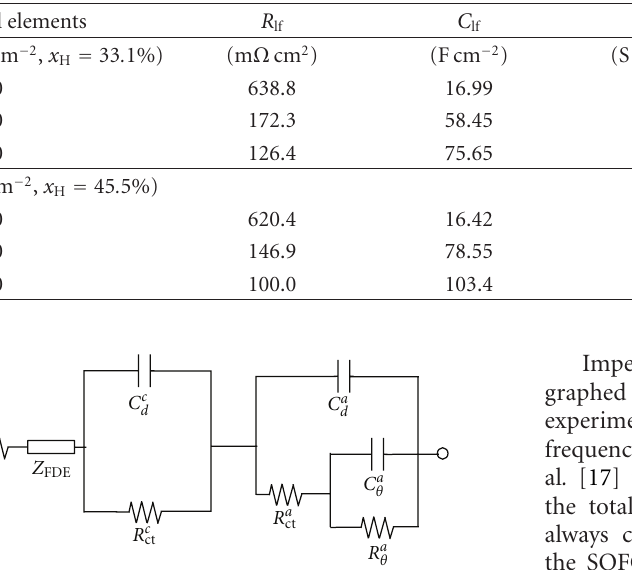
C a R c C c R a C a d , d , and θ θ ) ct ct